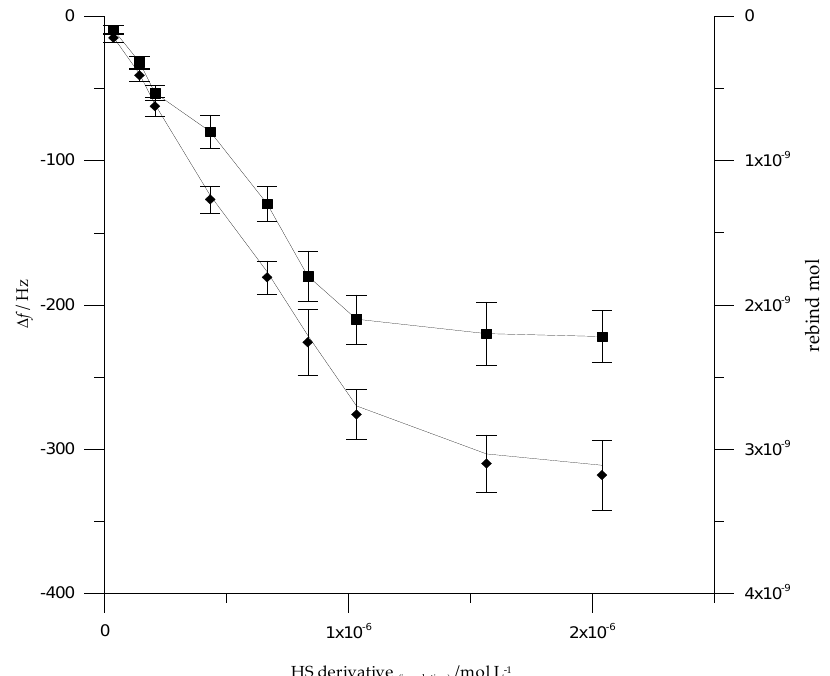
Figure 5. Calibration curves obtained by the rebinding test of cMIP prepared from 1 mM 5-pOH-DP/1 mM Acetyl-HS vs. Acetyl-HS as analyte (diamond symbol), and from 1 mM 5-pOH-DP/1 mM Cbz-HS vs. Cbz-HS as analyte (triangle symbol) in AN + 0.05 M TBAP; WE: Pt-quartz crystal electrode vs. Ag/Ag + RE and Pt-wire AE; scan rate 50 mVs −1 .